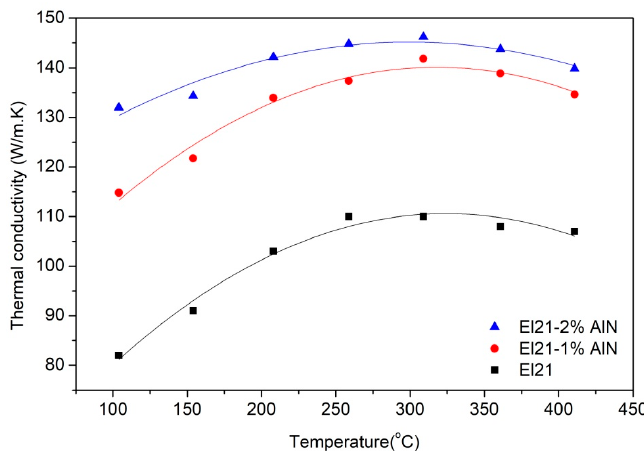
Figure 3. Temperature dependence of the Thermal conductivity of El21, El21-1%AlN and El21-2%AlN in as-cast condition.